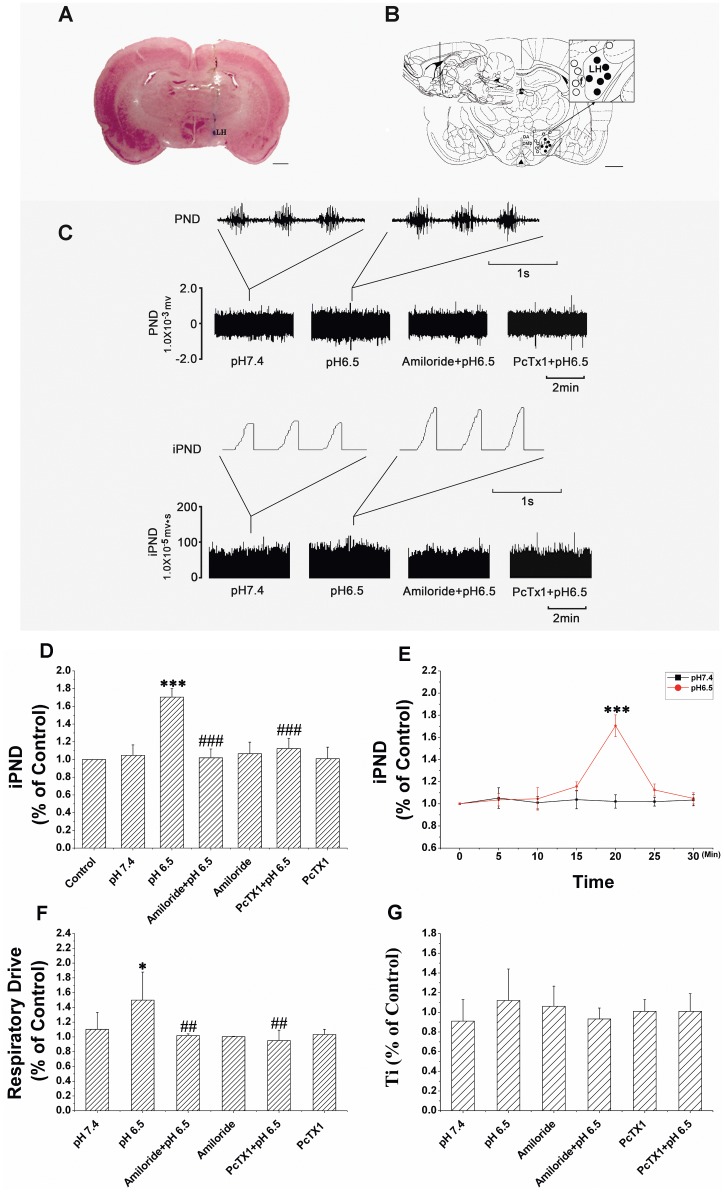
ASICs antagonist blocking acidification-induced increase of PND.A: Histological staining with neutral red: the sky blue spot was the injection site in the LH. Scale bar, 1 mm. B: Plot of the injection sites projected on Bregma −2.6 mm section: the solid dots were inside and the hollow ones outside of the LH. Scale bar, 1 mm. C: Unilateral microinjection of 0.1 µl ACSF (pH 6.5) into the LH increased raw PND (top) and iPND (bottom). Pre-treatment of amiloride (10 mM) or PcTX1 (10 nM) blocked the effect. Microinjection of ACSF (pH 7.4) served as the control. D: Group data show the effects of amiloride and PcTX1 on acidification-induced iPND (n = 6, *** P<0.001 relative to control, ### P<0.001 relative to pH 6.5). E: Time course of iPND response to acidification of the LH. Please note that the response peaked at 20 min (n = 6, *** P<0.001 relative to pH 7.4). F: Responses of respiratory drive (PA/Ti). Note that amiloride and PcTX1 inhibited the acidification-induced effect (n = 6, # P<0.05 relative to pH 7.4, ** P<0.01 relative to pH 6.5). G: Inspiratory time (Ti) was increased by acidification but not statistically significant (v.s. pH 7.4).